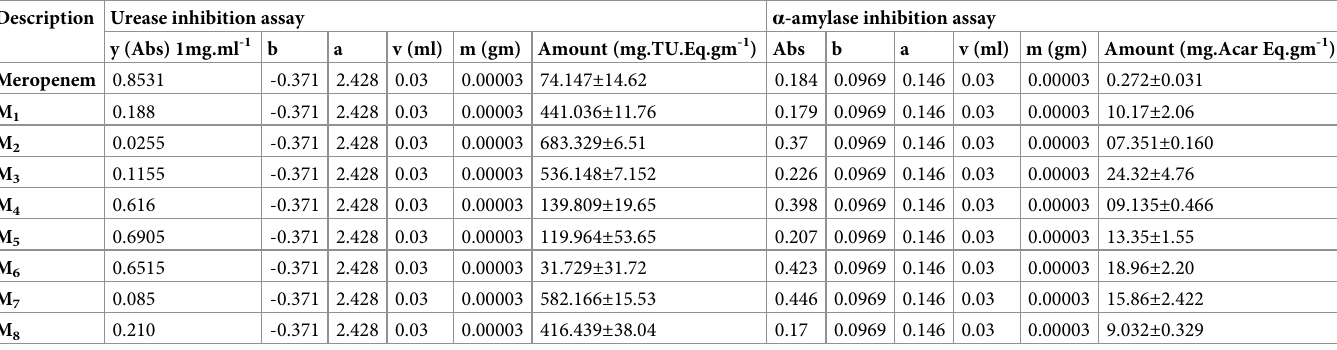
Table 2. The results of urease inhibition assay of meropenem and its derivatives. Description Urease inhibition assay